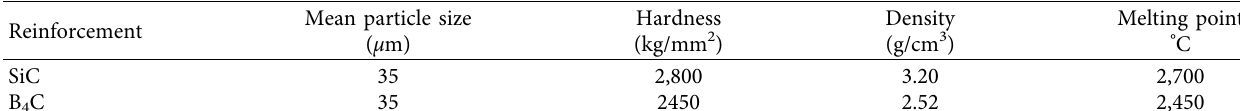
4 C particulate.